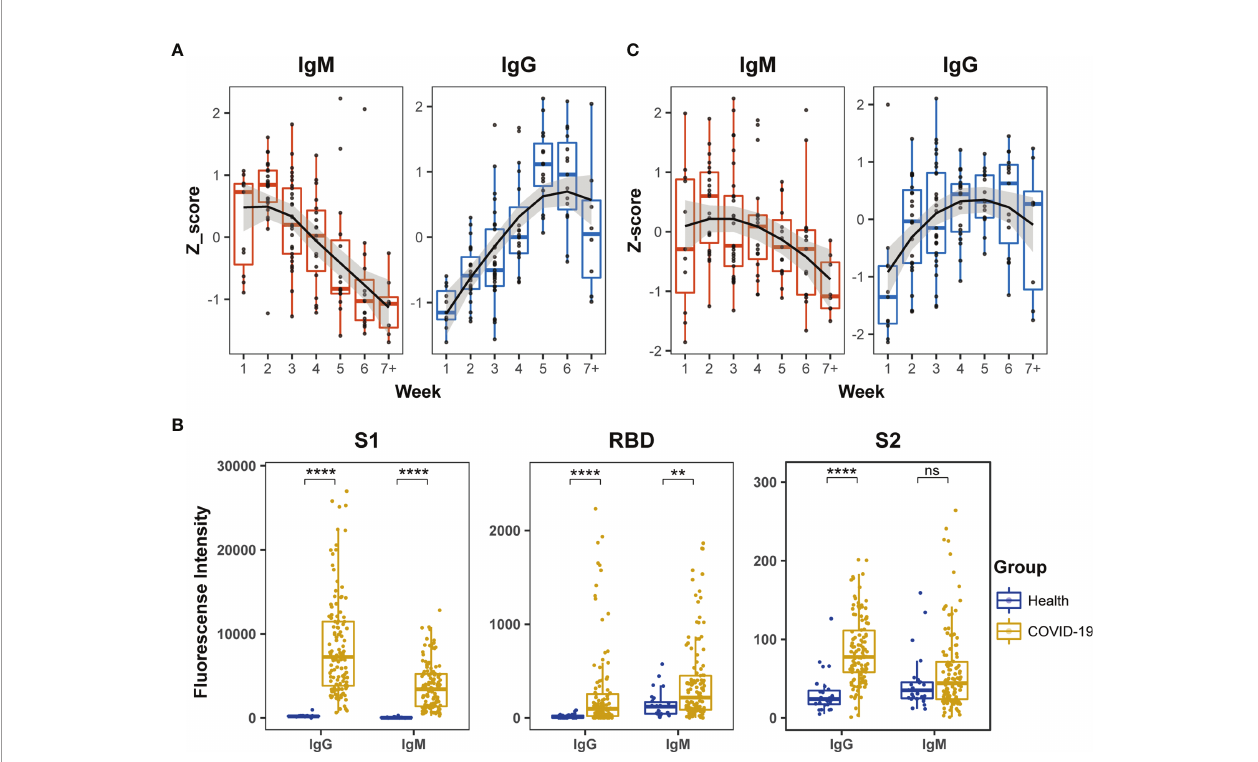
FIGURE 1 | Dynamic behaviors of humoral immune responses against S protein in COVID-19 patients. (A) The dynamic changes of IgM against N and recombinant S1 protein and IgG against the extract proteins from virus lysate based on ELISA. The signals of antibody responses in the patient serum samples were normalized by Z-scores and the trends of signal changes were mimicked by curve fi tting. (B) Comparisons of IgM or IgG immune signals against the truncated S proteins, S1, RBD and S2, between healthy subjects (n = 27) and all COVID-19 (n = 123) serum samples based on the microarray data. Unpaired Student ’ s t-test was used in the statistical analysis. Note: **p < 0.01, ****p < 0.0001, and ns, non-signi fi cance. (C) The dynamic changes of IgM and IgG against recombinant S1 protein based on